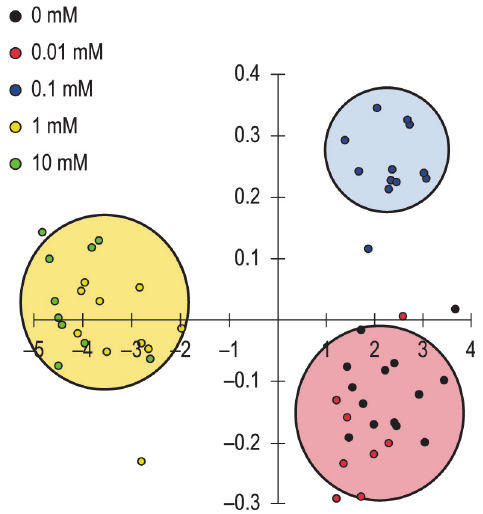
Figure 3. Discriminant analysis of the treatments of Cu in Salvinia auriculata